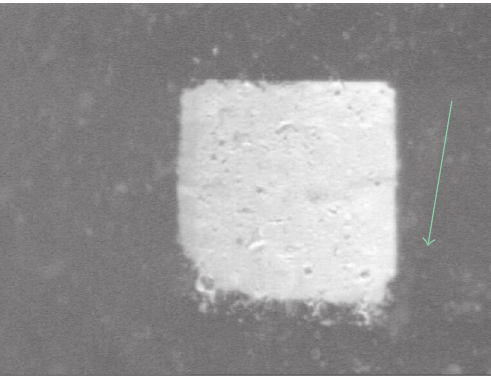
Figure 6: Collagen/PVP film surface after laser treatment ( F = 1 . 4J/cm 2 , 3 pulses). Green arrow indicates a material ejection; black area represents nonirradiated region of the collagen/PVP film.